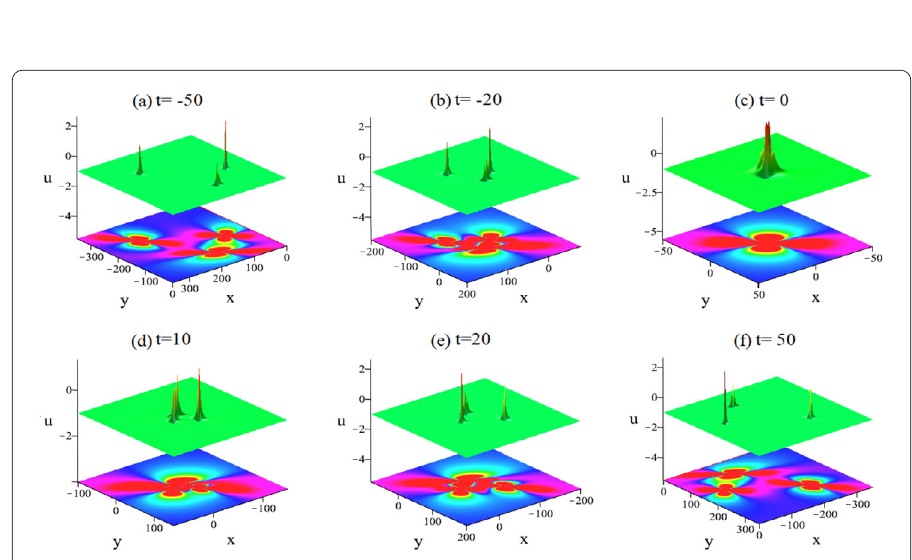
Figure 3 Surface (top) and density (bottom) plots of the interaction among three lumps with parameters in Eq. (14) at different